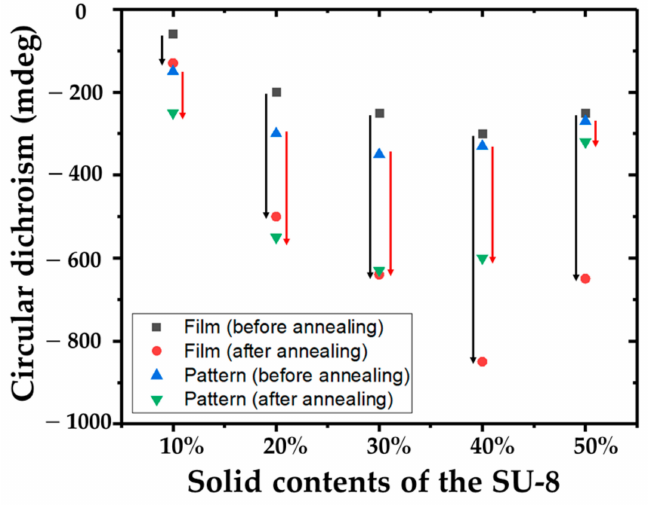
Figure 3. Measured maximum CD intensity before/after annealing of film/patterned. Structures (PFBT:SU-8 mixture ratio =